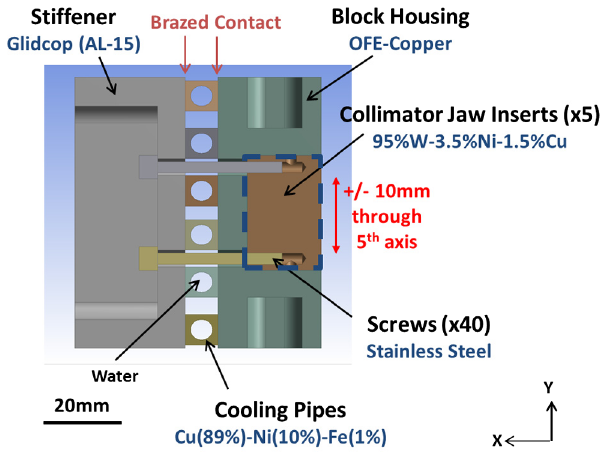
FIG. 3. Detailed cross section in the x - y plane of the TCT left jaw